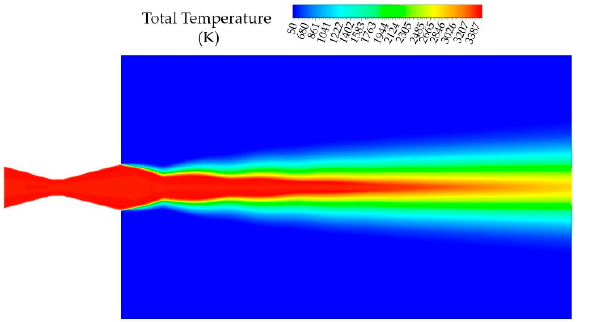
Figure 14. The total pressure at 1.2 s.